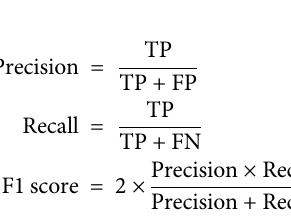
Frontiers in Pharmacology |